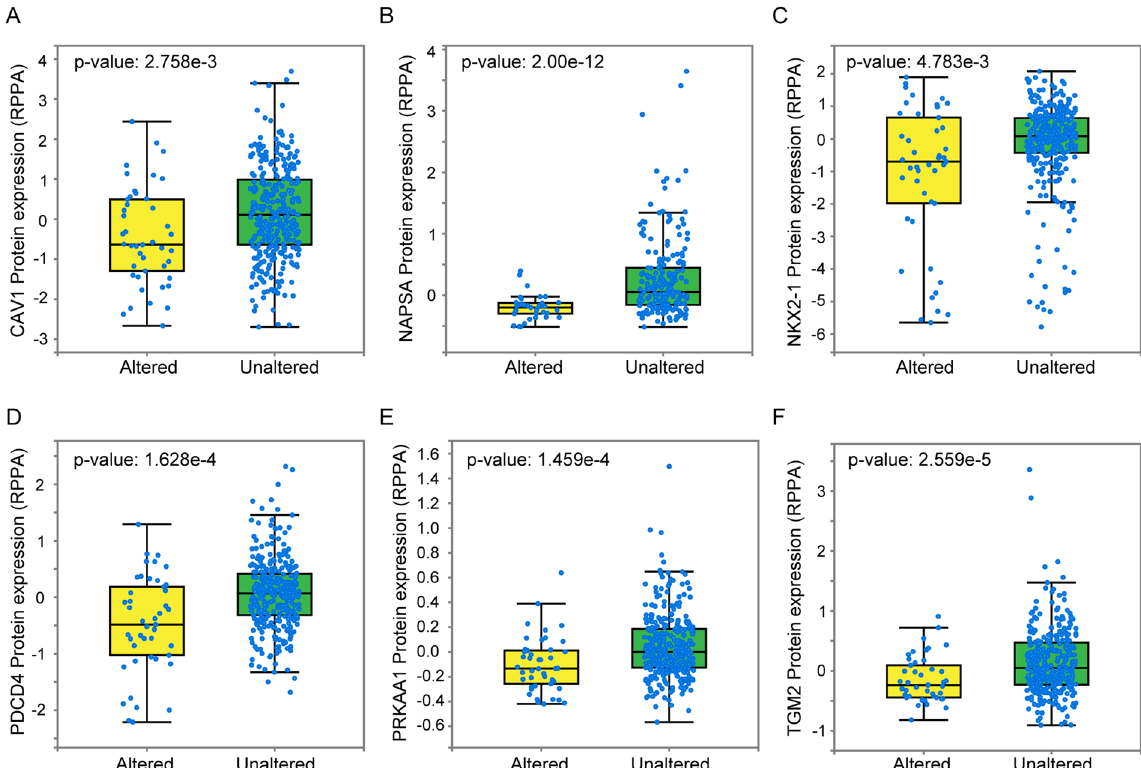
Figure 5. Significantly altered protein expression profiles in DTL overexpressing lung adenocarcinoma. Protein expression of CAV1 ( A ), NAPSA ( B ), NKX2-1 ( C ), PDCD4 ( D ), PRKAA1 ( E ) and TGM2 ( F ) in LuADCs overexpressing DTL (Altered) compared to tumors that do not overexpress DTL